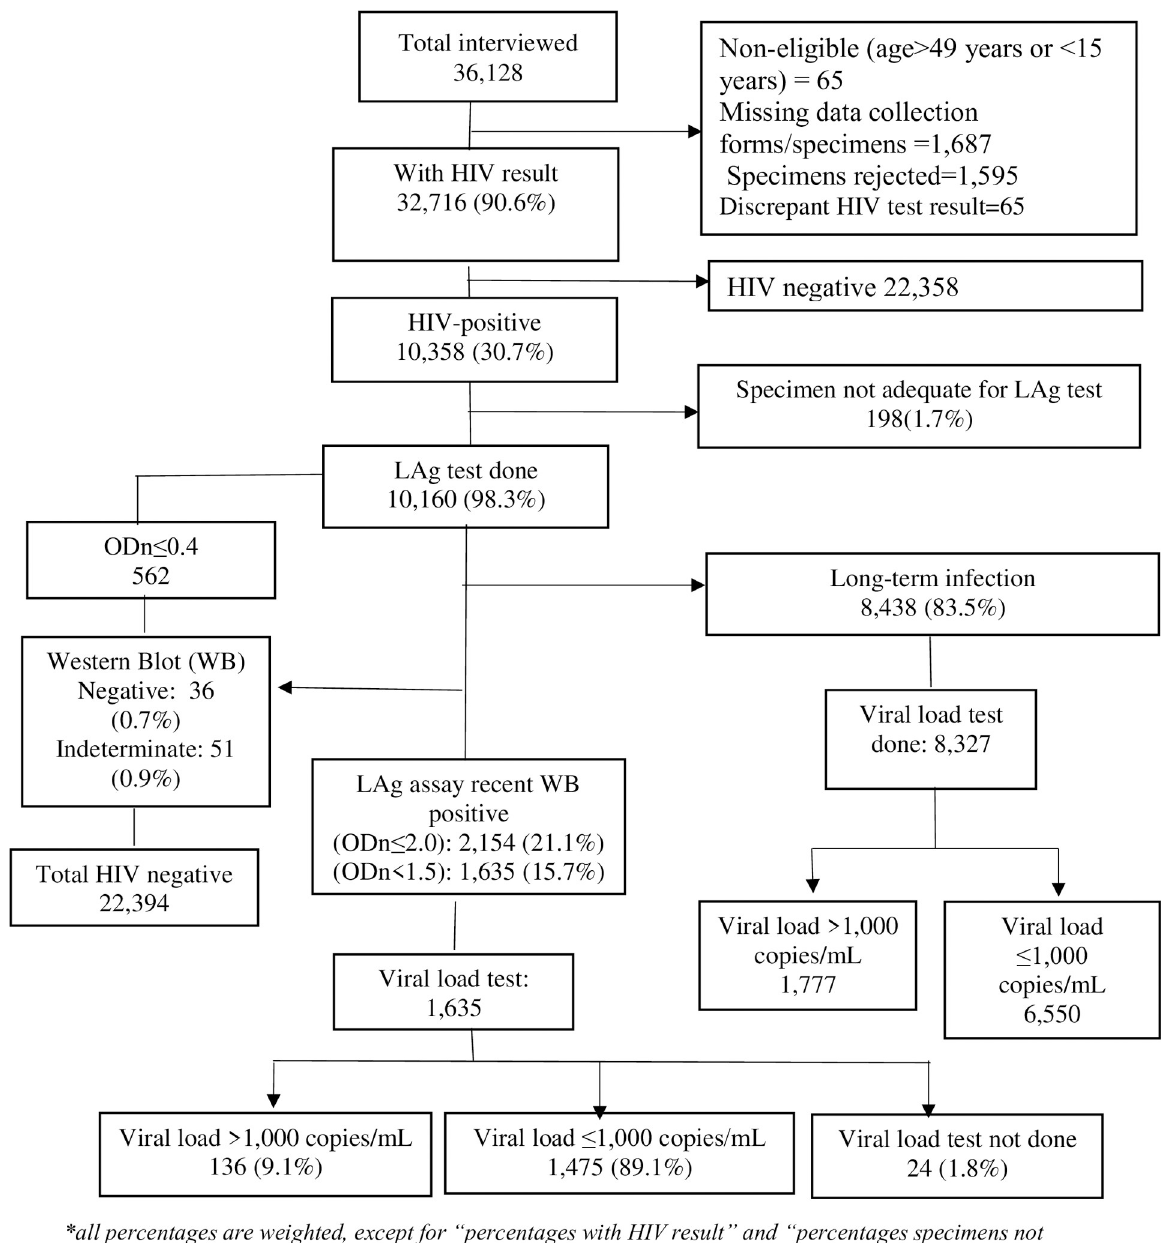
Fig 3. Recent infection algorithm, Antenatal HIV Sentinel Survey, 2017, South Africa.